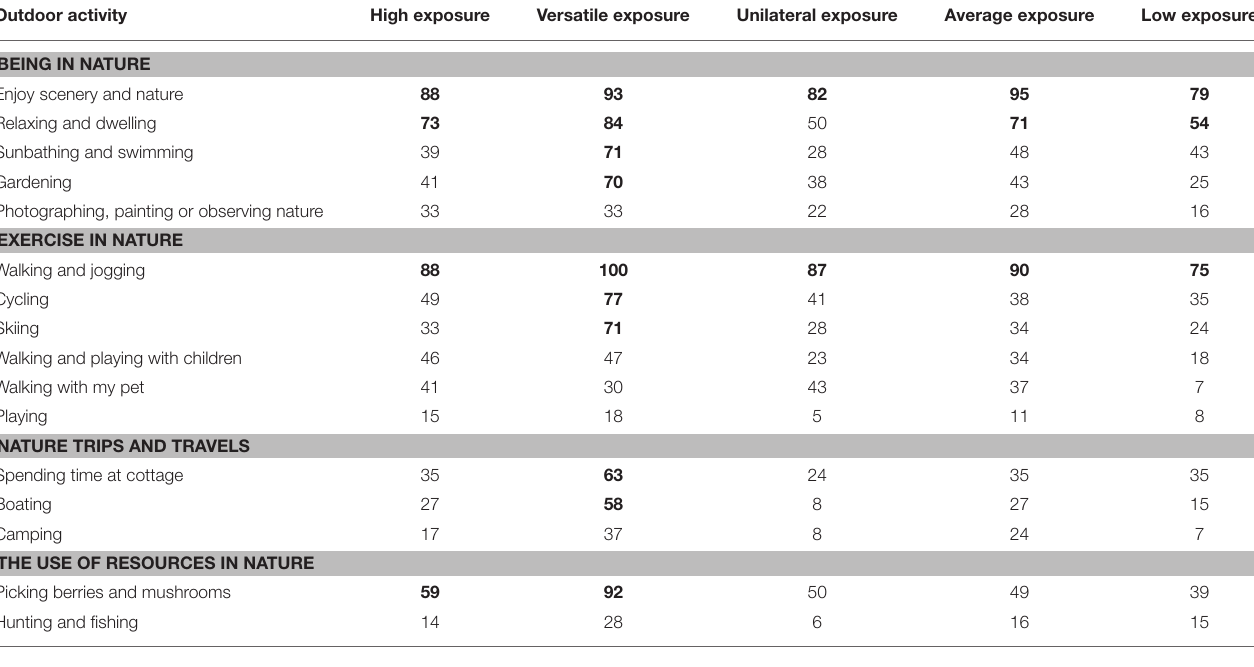
TABLE 5 | Percentages per profile of participants engaging in each of the different outdoor activities in nature environments during leisure time (activities in which over 50% of participants in each profile engaged are marked in bold). Outdoor activity High exposure Versatile exposure Unilateral exposure Average exposure Low exposure